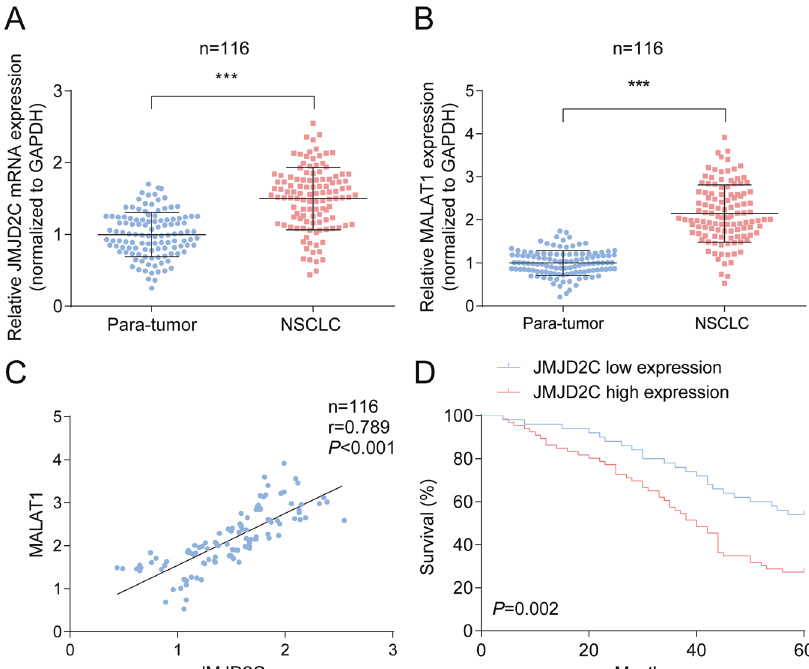
Fig. 1 JMJD2C-related MALAT1 is highly expressed in NSCLC tissues. A RT-qPCR analysis of JMJD2C in NSCLC tissue; B RT-qPCR analysis of MALAT1 in NSCLC tissue; C Correlation between JMJD2C and MALAT1; D Relation between JMJD2C expression and survival of patients with NSCLC. *** P < 0.001; Data statistics was by t -test, Pearson ’ s correlation analysis, Kaplan – Meier analysis.